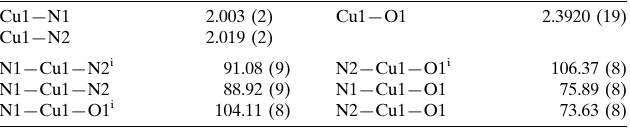
Selected geometric parameters (A˚ , (cid:1) ).